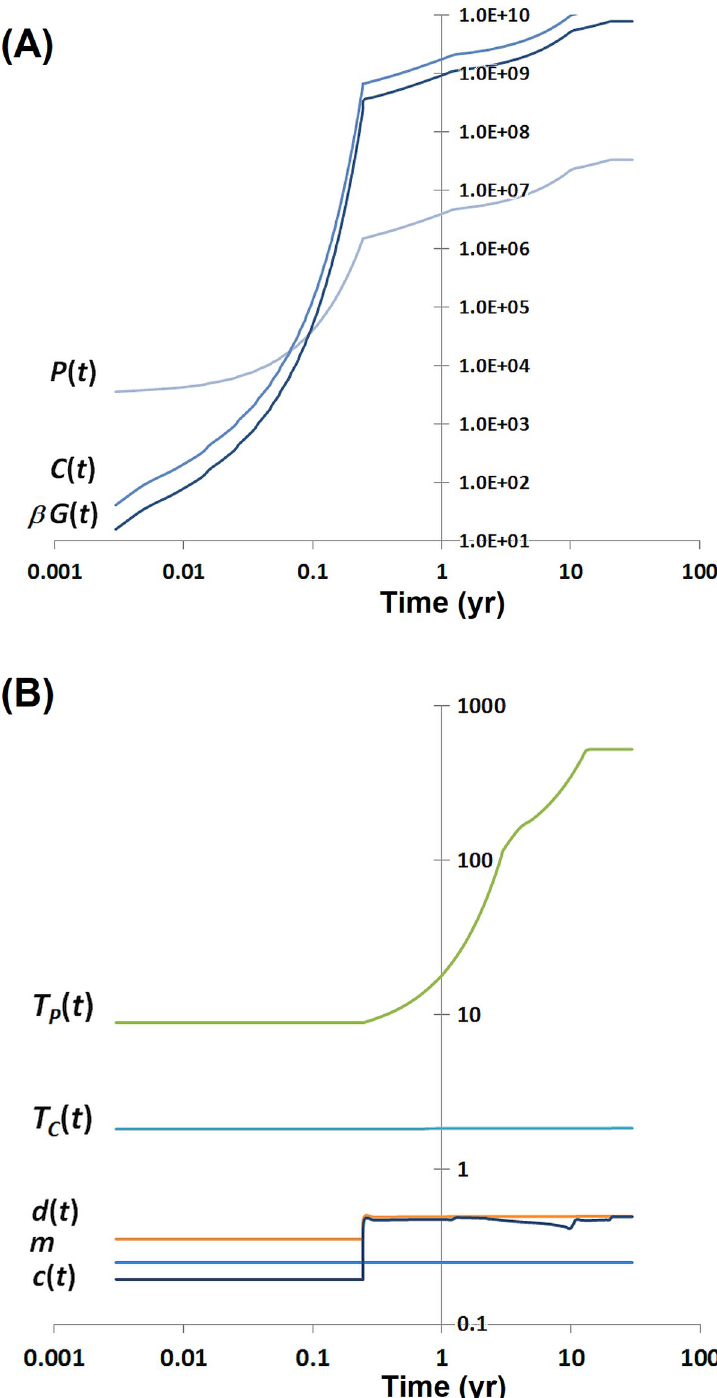
Fig 6. Estimated dynamics of human hematopoiesis in the bone marrow, starting from its onset in the final weeks of fetal life. (For additional details see the twin sections titled Estimates of the parameters of the model of age-dependent dynamics of the granulocyte arm of the hematopoietic system , in the Results and in the S1 Appendix ). (A) Counts of the HSCs ( P ð t Þ ) and CMPs ( C ð t Þ ), and the rate of granulocyte production per day ( b G ð t Þ ), as a function of time (individual’s age), calculated for human body weight following the Theron’s formula. (B) Time (individual’s age) dependent parameters of the mathematical model of the human hematopoietic system: expected time (days) between HSC divisions T t ð Þ ¼ 1 = a ð t Þ , expected time (days) between CMP divisions T t ð Þ ¼ 1 = b ð t Þ , maturation probability P C